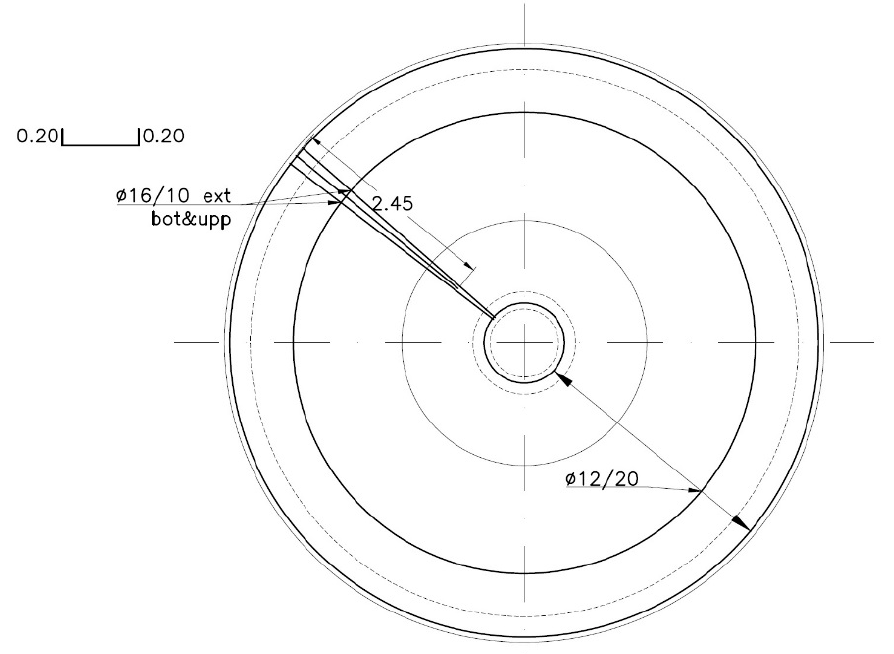
Figure 5. Reinforcement plan view of the bottom slab of the reservoir.